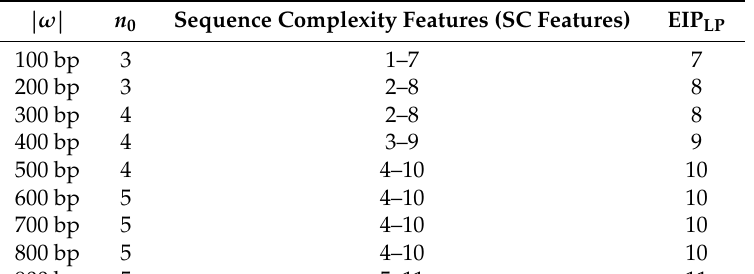
Table 8. The determinations of seven sequence complexity features of different window sizes. | ω | represents the length of window, and n 0 represents the topological entropy point in reference [35]. | ω | n 0 Sequence Complexity Features (SC Features)